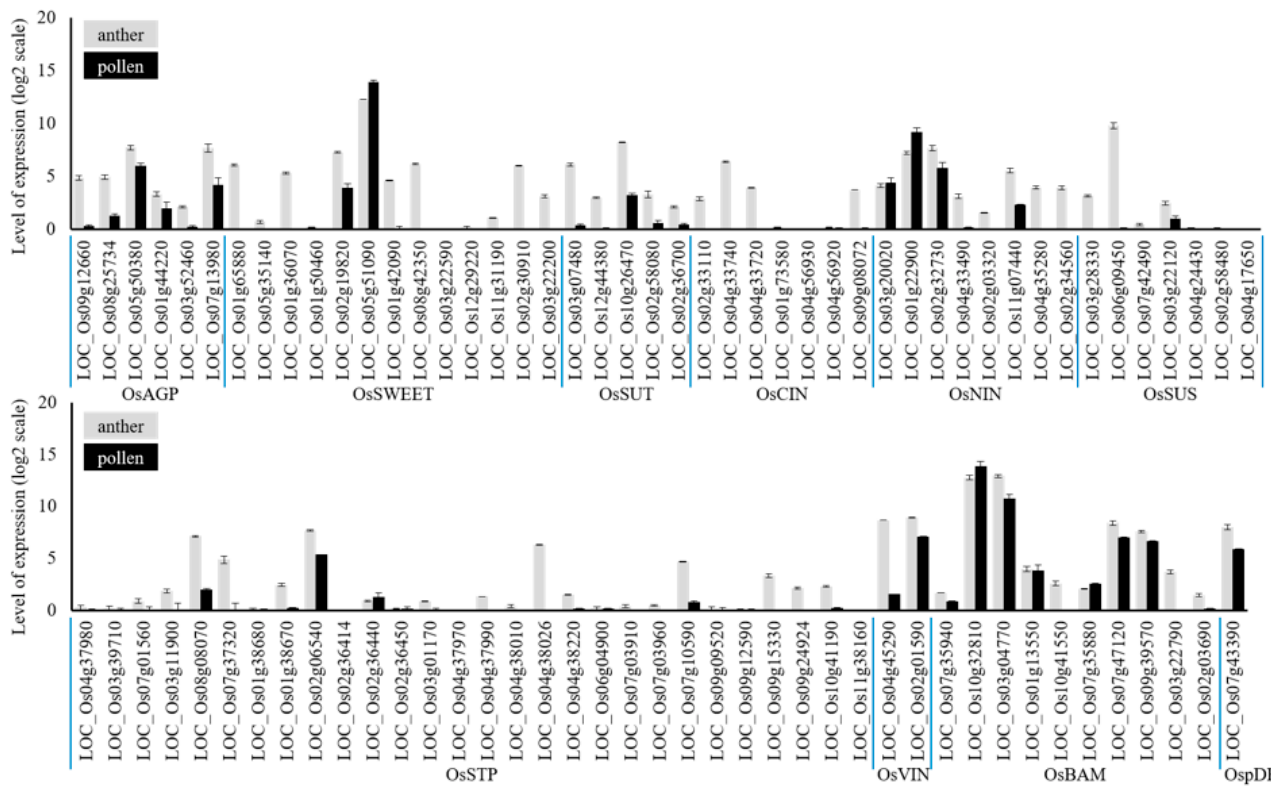
Figure 3. Transcript levels of sugar and starch metabolism genes in rice anther and pollen. The information was extracted from Genevestigator.